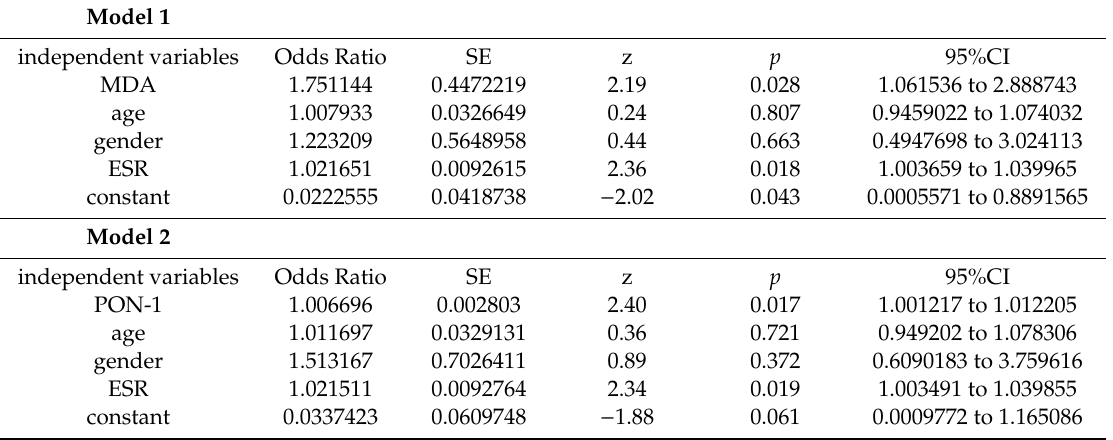
Table 6. Independent determinants of the presence of peripheral endothelial dysfunction (ED) in RA